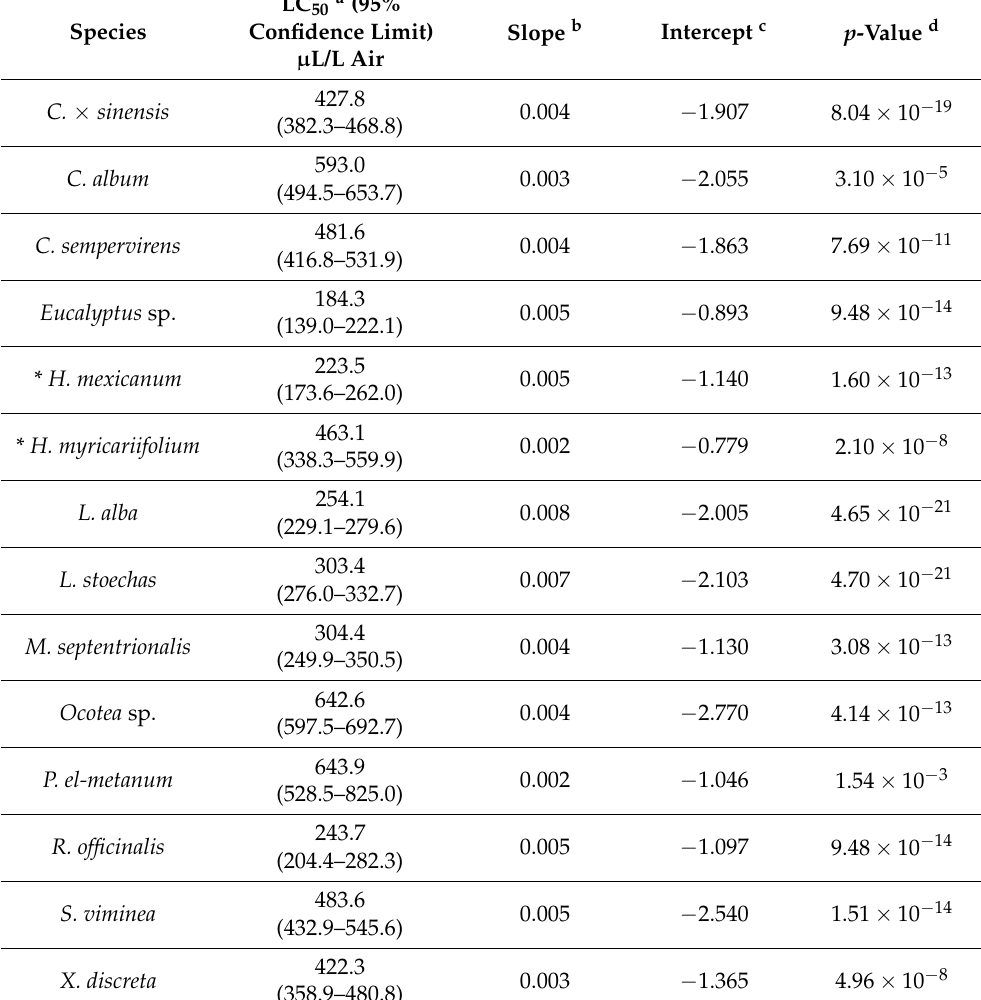
Table 3. Fumigant toxicity for the 14 EOs, expressed as median lethal concentrations (LC 50